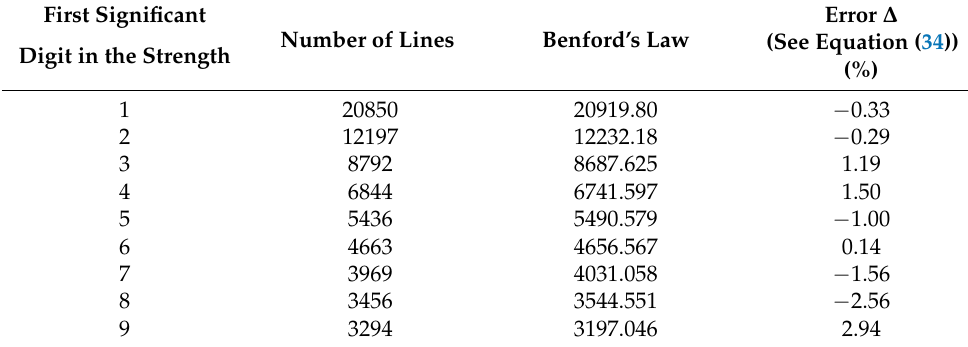
2 p 33 d 1 4 f 1 . − Exact ( column 3 )) /Exact ( column 2 ) −